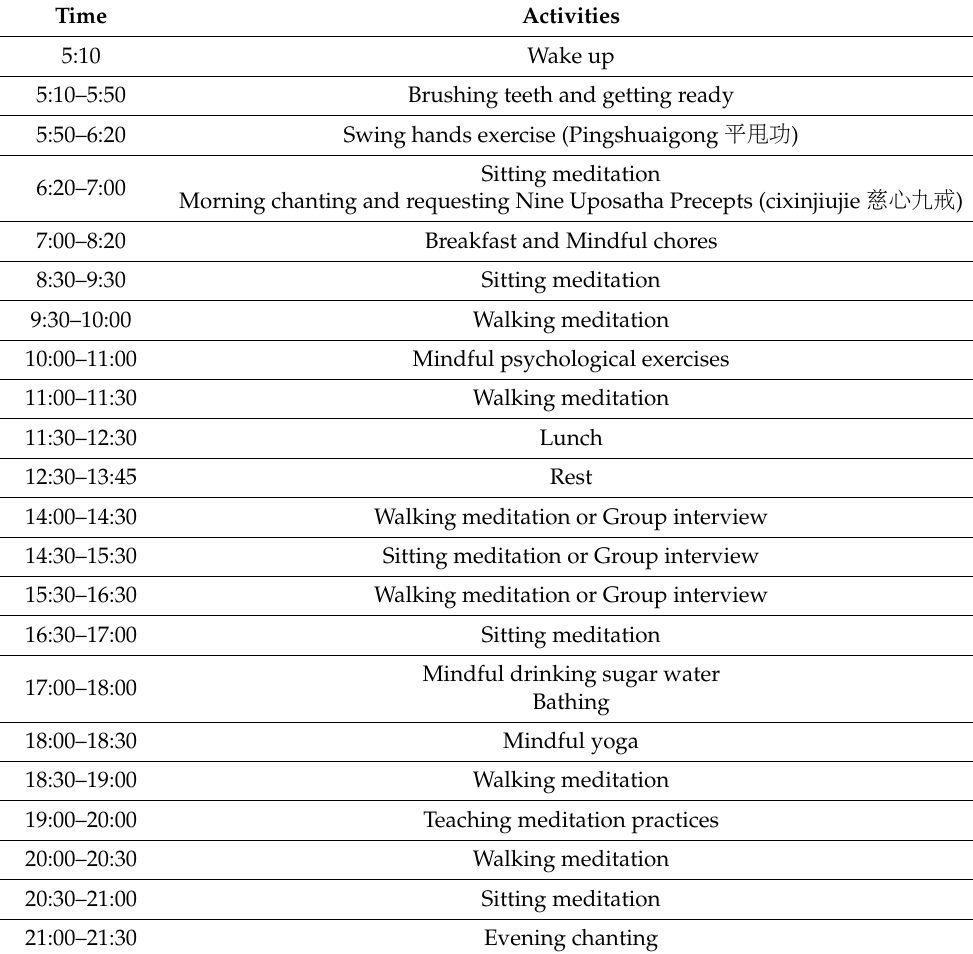
Table 1. Daily schedule of Healing Depression Vipassan¯a Meditation Retreat at Gengxiang Monastery in Winter Solstice 2019.